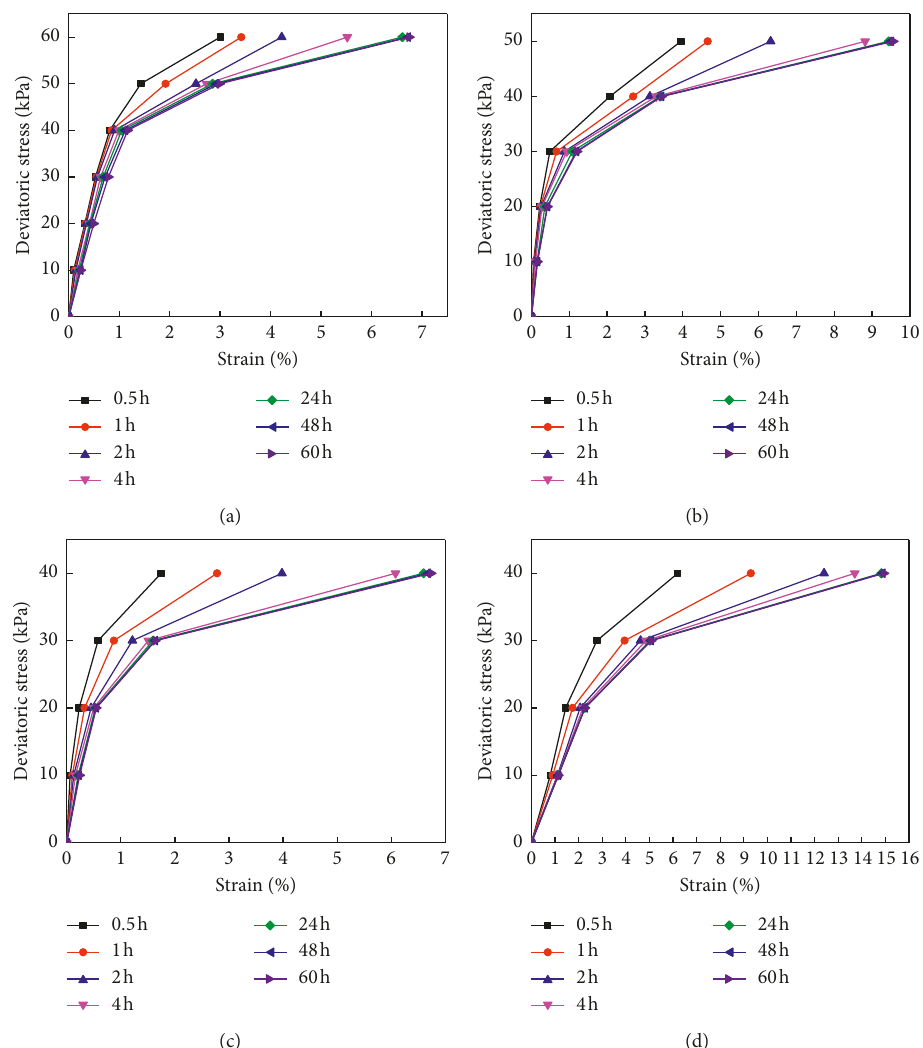
Figure 3: Unloading creep deviatoric stress-strain curves of soft soil under different initial excess pore water pressure (consolidation confining pressure 100kPa). (a) Initial excess pore water pressure u 0 0kPa. (b) Initial excess pore water pressure u 0 20 kPa. (c) Initial (cid:31) (cid:31) excess pore water pressure u Table 3: The fitting relationship between creep yield stress and initial pore water pressure. Consolidation confining pressure